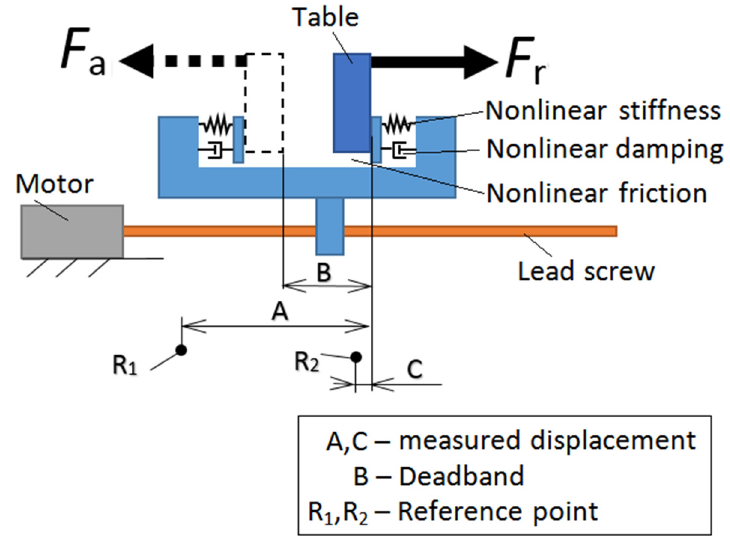
Figure 14. Table Positioning Model, inspired by the ISO 230 ‐ 2 [34] standard.